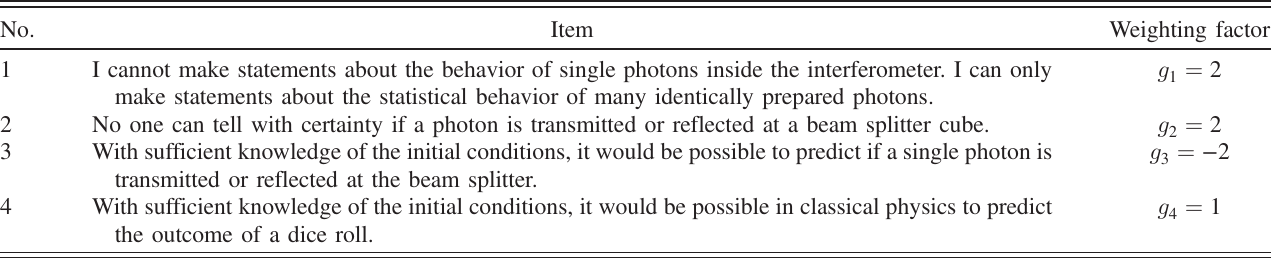
TABLE III. Items from the questionnaire on students ’ conceptions according to Müller [66] and translated into the setting single photon in the interferometer composing the scale the probability interpretation of quantum physics. No.